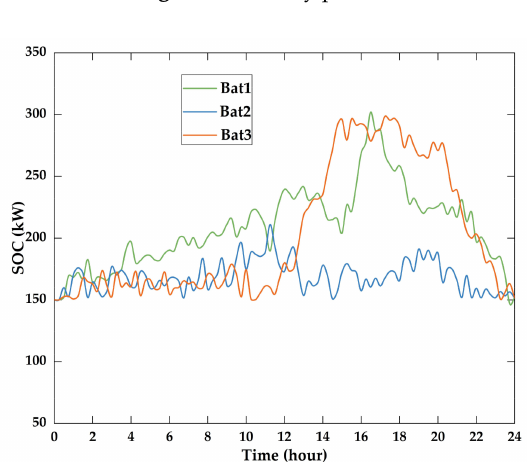
Figure 22. SOCs of